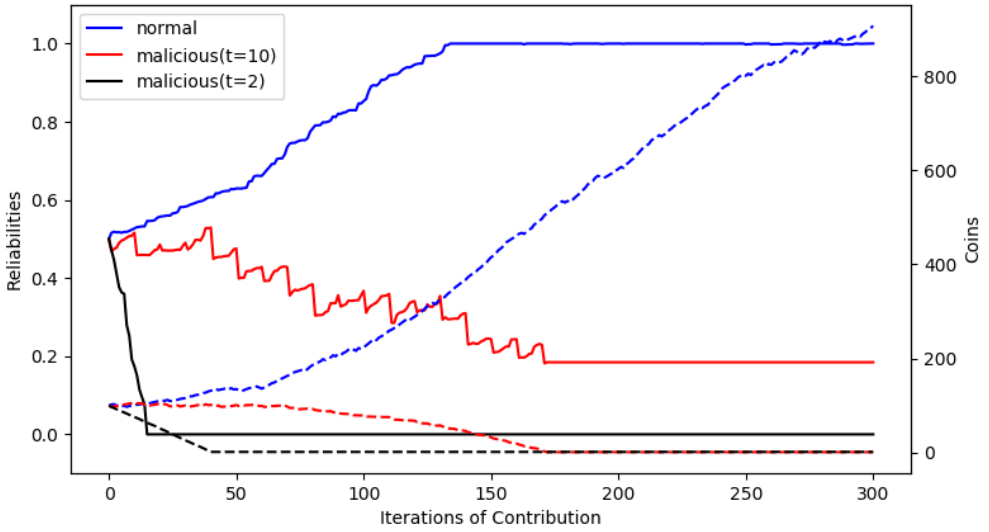
Figure 5. Reliability and property (cryptocurrencies) trends on each contributor and attacker (solid lines show the reliability and dashed lines shows the